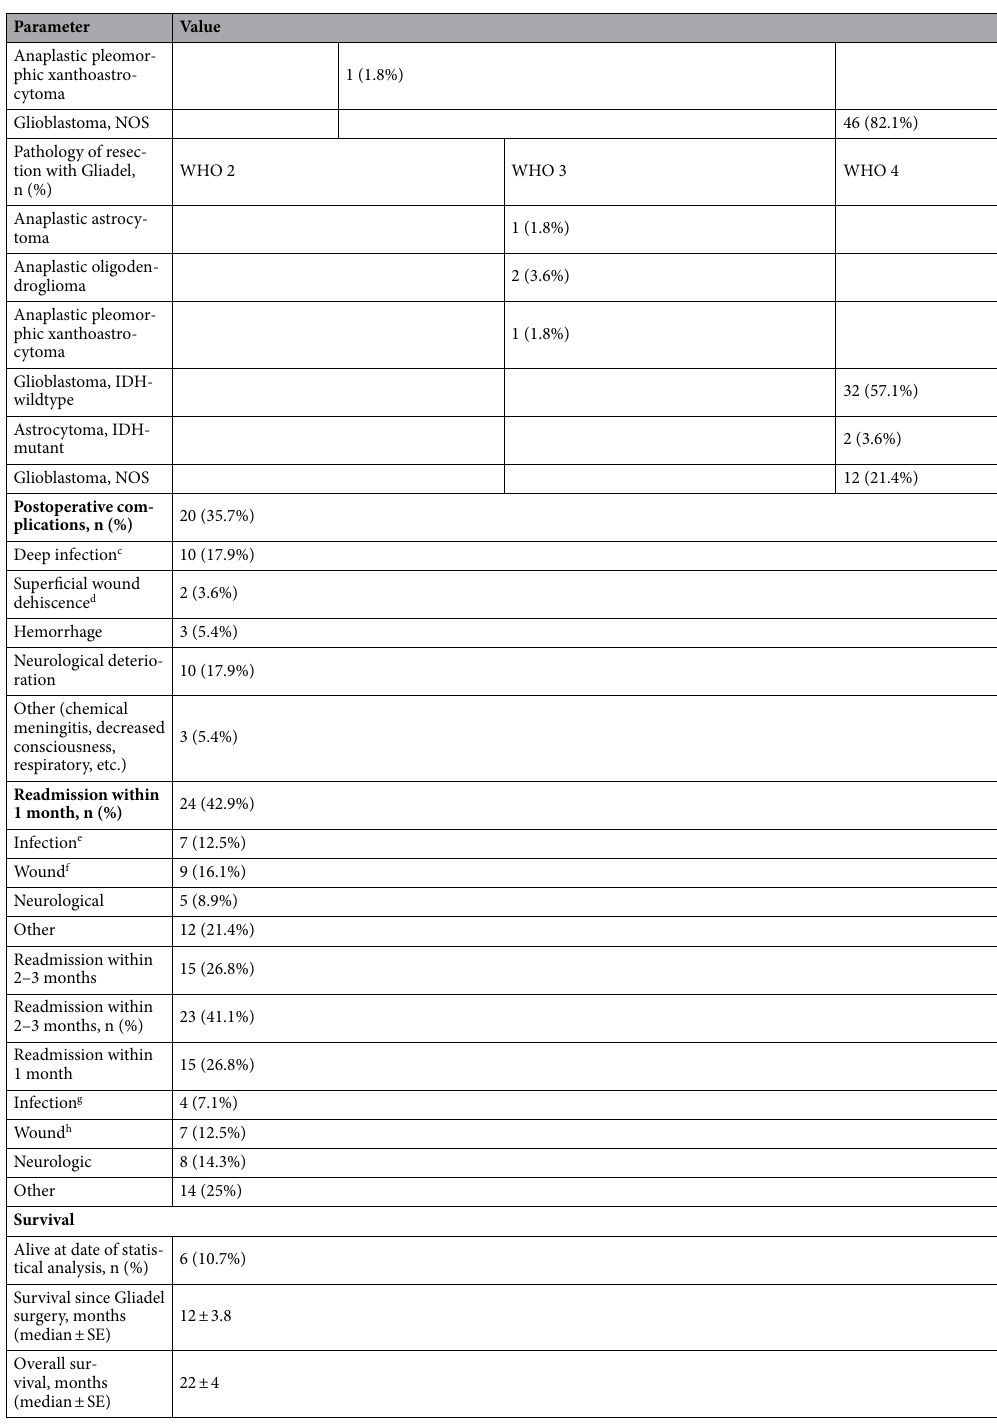
Table 1. Demographics and clinical characteristics of 56 patients who underwent implantation of gliadel wafers for recurrent glioblastoma between 2005 and 2016. SE standard error. a Some patients had more than 1 lobe involvement. b Given in percent, calculated on TB volumes between pre-operation and immediately post-operation (35 patients). c Meningitis, osteomyelitis, abscess (including readmission in 1 month). d Wound dehiscence, CSF leak, pseudo-meningocele requiring hospitalization (during immediate postoperative period). e,f During readmission within 1 month post-operation. g 1 of them was infected during the immediate postoperative period. h 3 of them had wound pathologies during the immediate postoperative